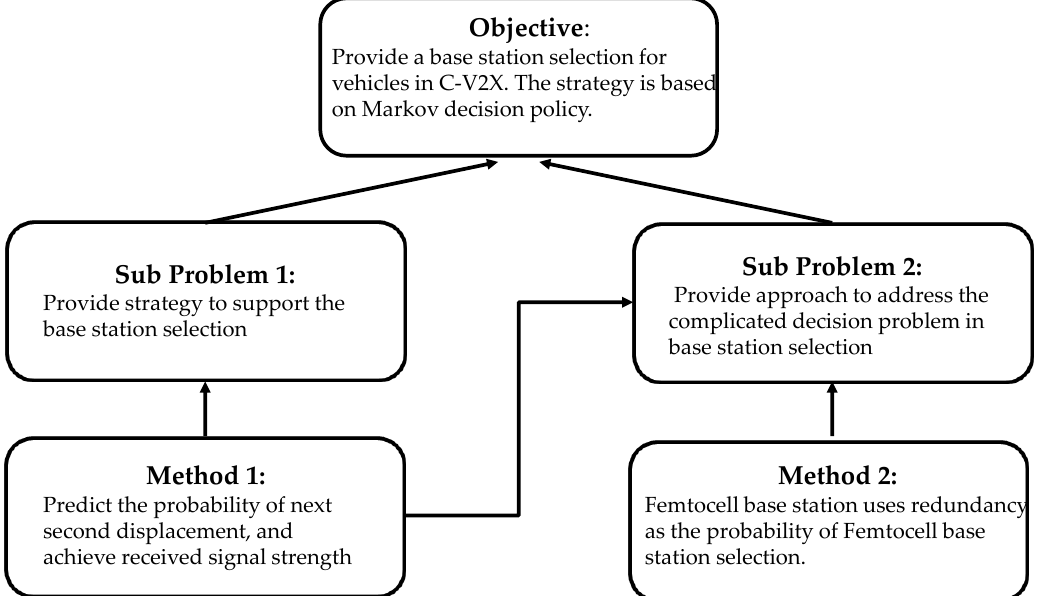
Figure 2. Basic idea of base station selection, presenting the objective, subproblems, and methods. C-V2X, cellular